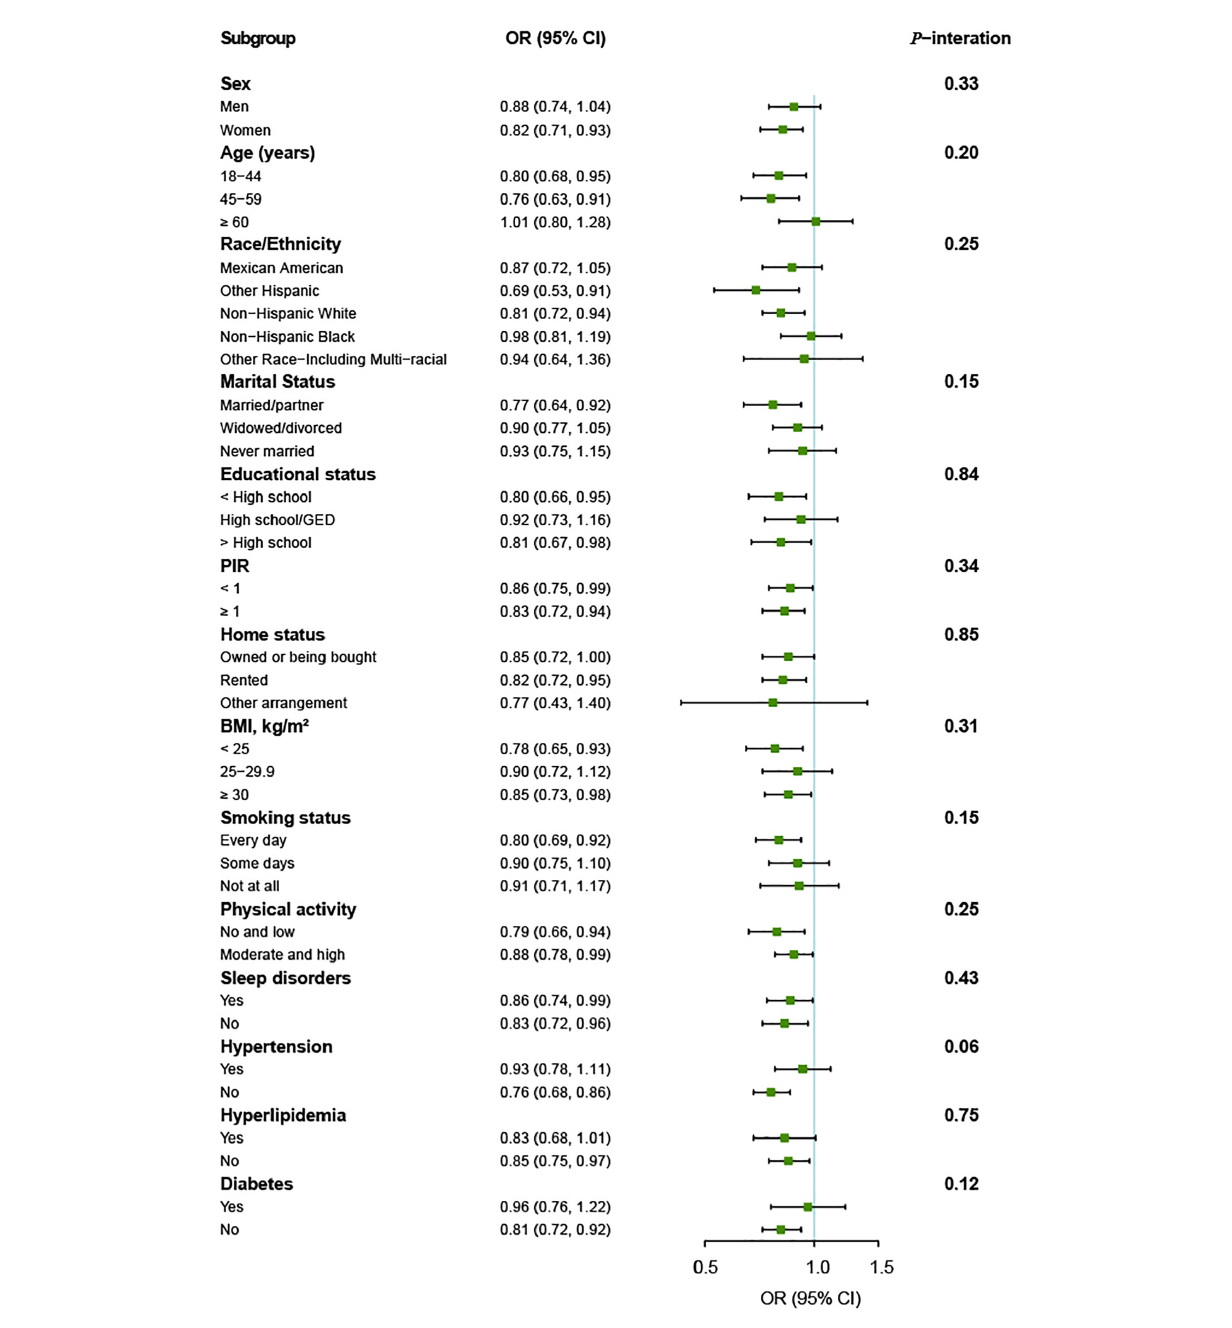
FIGURE3 Vitamin K intake and depressive symptoms by different characteristics of the participants ( n = 11,687). OR (95% CI) are reported per 1-SD increment of log-transformed vitamin K intake. The models were adjusted for age (18–44, 45–59, or ≥ 60 years), sex (men or women), race/ethnicity (Mexican American, other Hispanic, non-Hispanic White, non-Hispanic Black, or other Race-Including Multi-racial), marital status (married/partner, widowed/divorced, or never married), educational status ( < high school, high school/GED, or > high school), PIR ( < 1 or ≥ 1), home status (owned or being bought, rented, or other arrangement), BMI ( < 25, 25–29.9, or ≥ 30 kg/m 2 ), smoking status (every day, some days, or not at all), physical activity (no and low or moderate and high), sleep disorders (yes or no), hypertension (yes or no), hyperlipidemia (yes or no), and diabetes (yes or no). BMI, body mass index; GED, General Educational Development; PIR, ratio of family income to